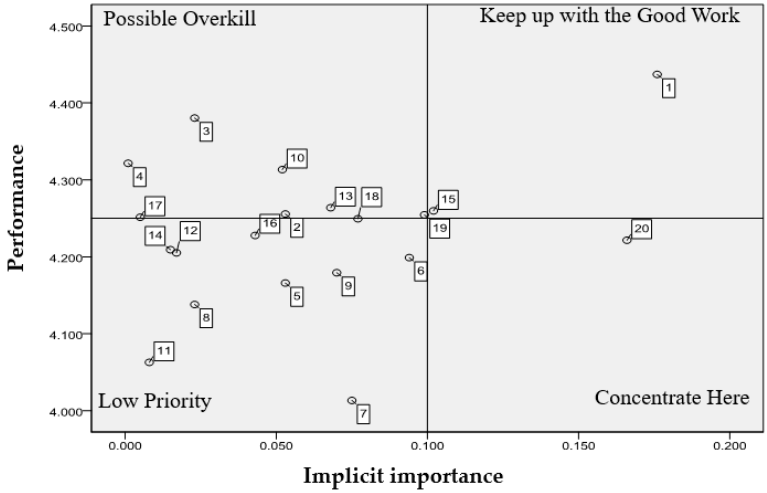
Figure 3. RIPA grid—teaching quality indicators of physical education.